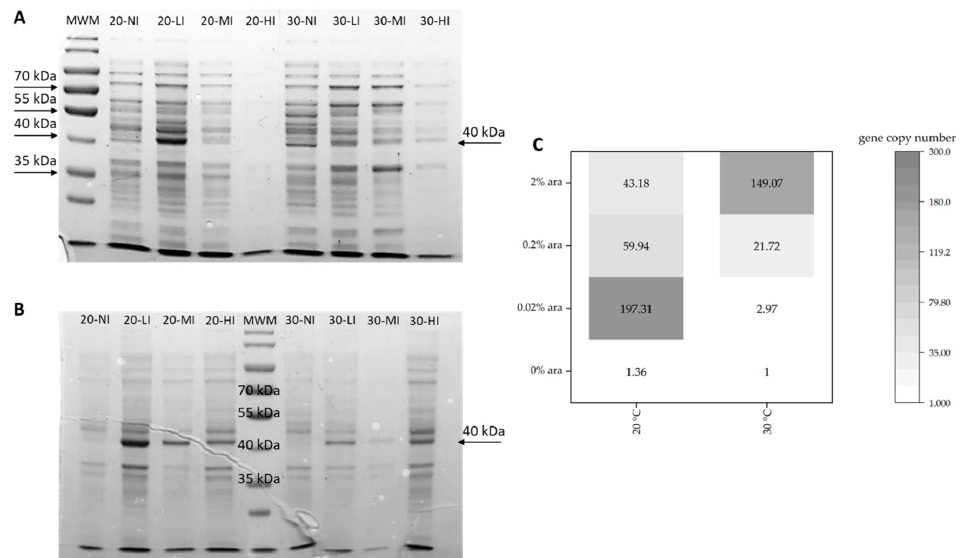
Figure 4. SDS-PAGE ( A , B ) and RT-qPCR ( C ) analysis in different level of arabinose and temperatures (BL21_ efe_PS + as a representative). ( A ) Crude extract in supernatant; ( B ) Crude extract in insoluble fraction. The temperature, arabinose concentration and proportion of target protein in each channel of supernatant is: MWM: protein ladder (10–180 kDa, Thermofisher, Waltham, MA, USA); 20-NI: 20 ◦ C, 0% ara: 8.2% proportion; 20-LI: 20 ◦ C, 0.02% ara: 13.5% proportion; 20-MI: 20 ◦ C, 0.2% ara: 8.8% proportion; 20-HI: 20 ◦ C, 2% ara: 6.1% proportion; 30-NI: 30 ◦ C, 0% ara: 8.9% proportion; 30-LI: 30 ◦ C, 0.02% ara: 10.6% proportion; 30-MI: 30 ◦ C, 0.2% ara: 9.1% proportion; 30-HI: 30 ◦ C, 2% ara: 10.3% proportion.